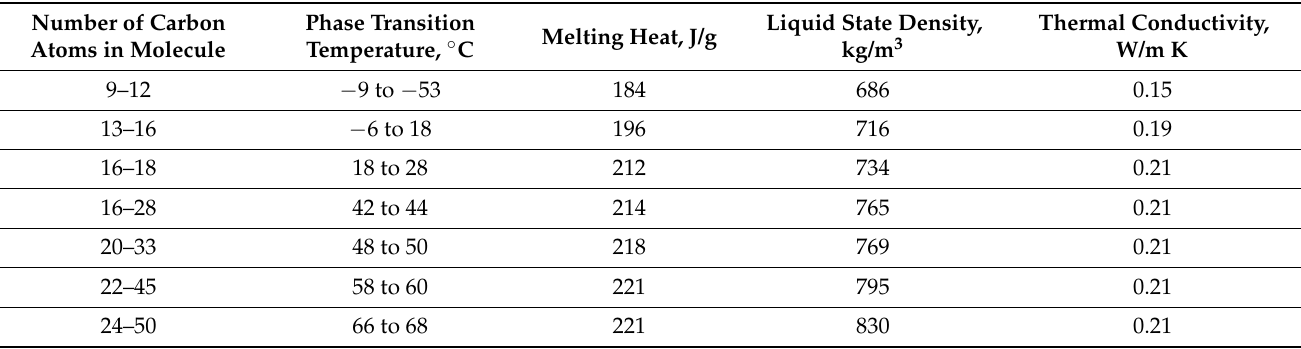
Table 1. Thermophysical properties of commercial paraffin waxes [27] with a specific heat capacity of 2.1 J/g K.